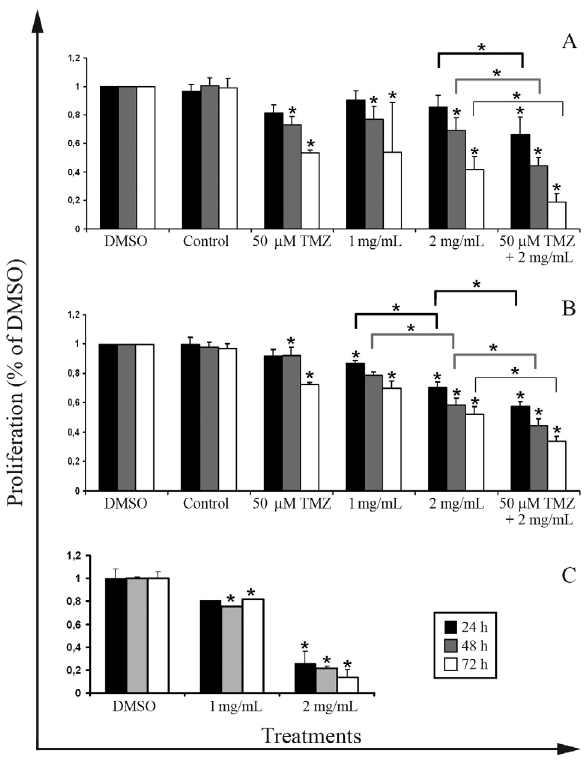
at the concentrations of 1 and 2 mg/mL for 24, 48 and 72 h. Glioblastoma cellswerealsotreatedwithtemozolomide(TMZ)combinedwithpropolis. Asterisks indicate a statistically significant difference between groups. A. U251, B. U343, C.